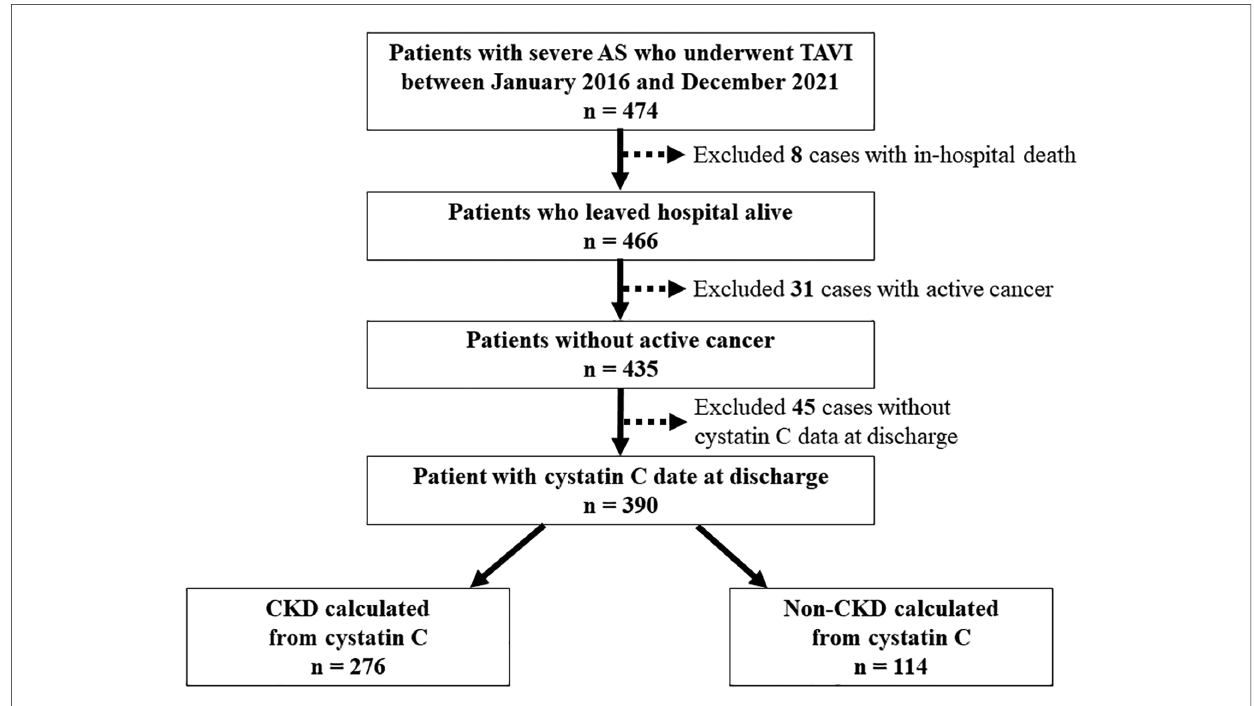
FIGURE 1 Flowchart of patient selection. AS, aortic stenosis; CKD, chronic kidney disease; TAVI, transcatheter aortic valve